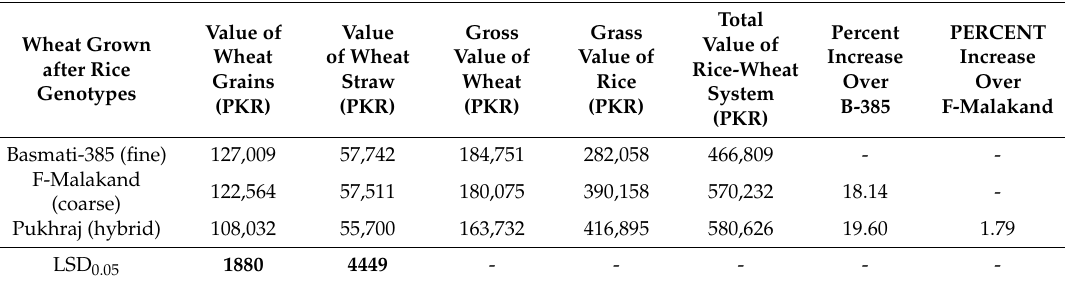
Table 7. Impact of the preceding rice genotypes on the economic analysis of subsequent wheat crop under rice–wheat cropping